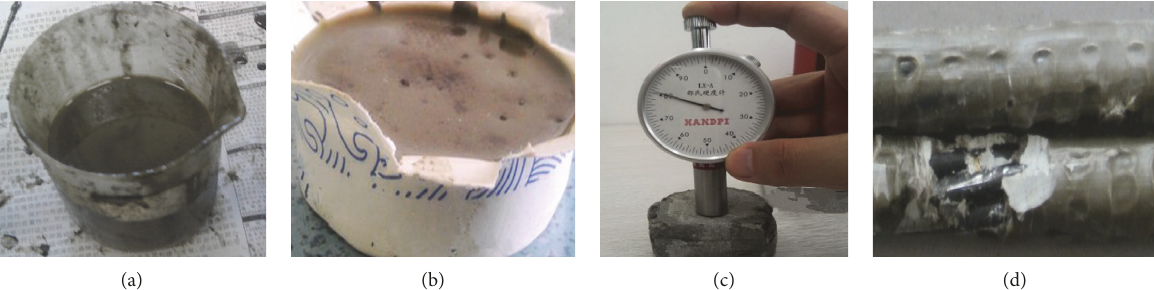
Figure 7: Apparent state and Shore hardness of retarder at different stages of curing. (a) Fluid state and 0. (b) Semifluid and 60.8. (c) Solid and 80.5. (d) Solid and 93.0.